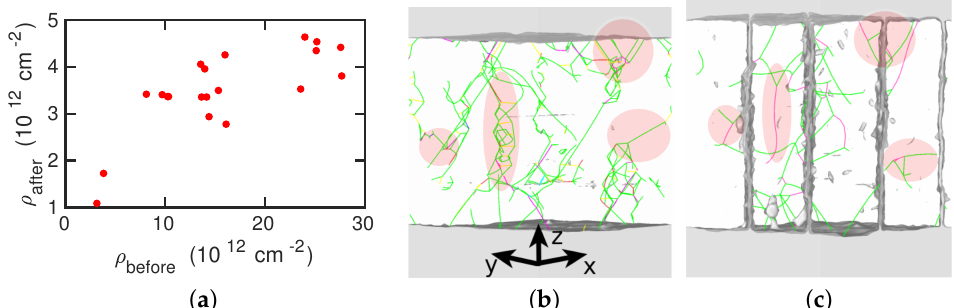
Figure 11. ( a ): Comparison of the dislocation density before and after the martensitic phase transition; ( b , c ) snapshots of a specimen with a dislocation density of 10.34 × 10 12 cm − 2 before ( b ) and after ( c ) the transformation. The colors denote the dislocation type as in Figure 1. Pink areas highlight corresponding regions before and after the transformation. In ( c ), gray vertical structures denote twin boundary [ 1¯12 ] bcc planes in the transformed bcc